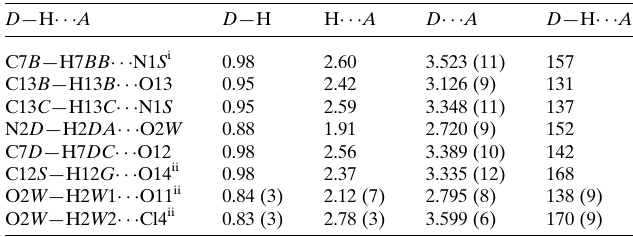
Table 2 Hydrogen-bond geometry (A˚ , (cid:5) ).